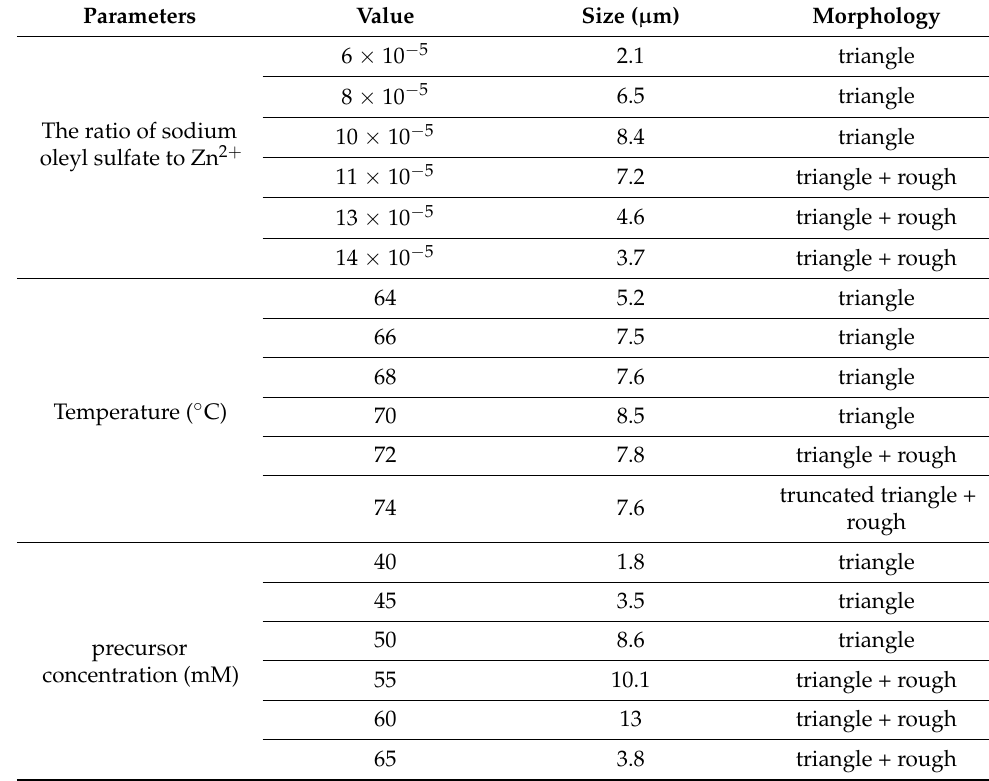
Figure 4. Controlling the growth of 2D ZnO by growth time. Controlling the growth of 2D ZnO with a time of ( a ) 40 min, ( b ) 45 min, ( c ) 50min, ( d – f ) 55 min, 60 min and 65 min. Insets are the corresponding EDS mapping images of Zn and Na elements. Scale bar is 1 µ m. Table 1. Effect of the above parameters on 2D ZnO